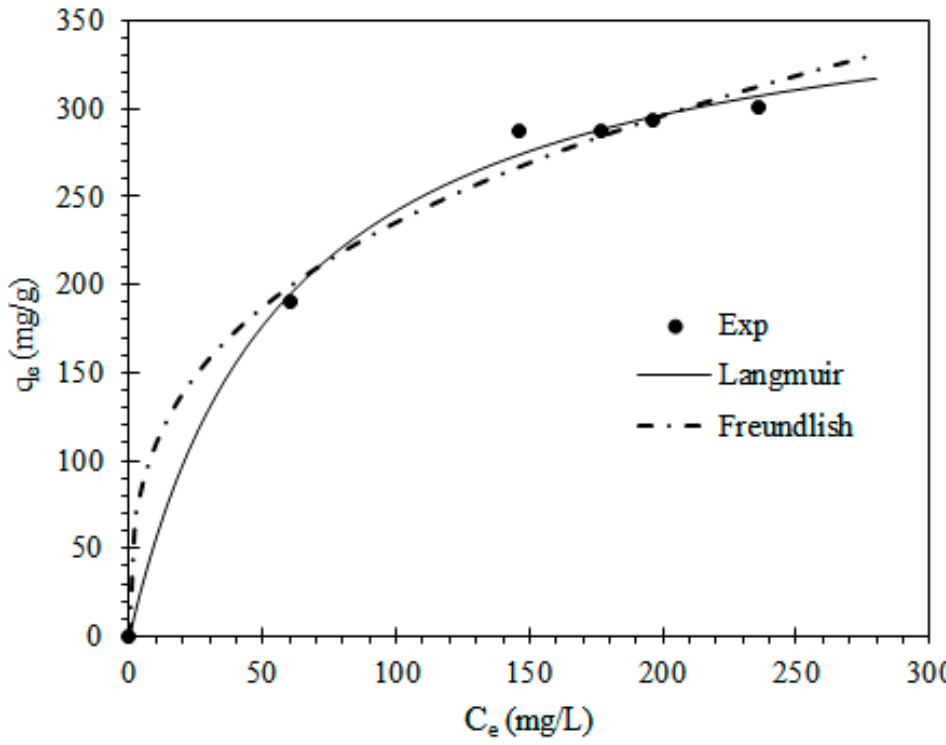
Figure 7. Isotherm plots for COD removal by sugarcane bagasse. Table 6. Comparison of the q max of COD removal by various adsorbents.